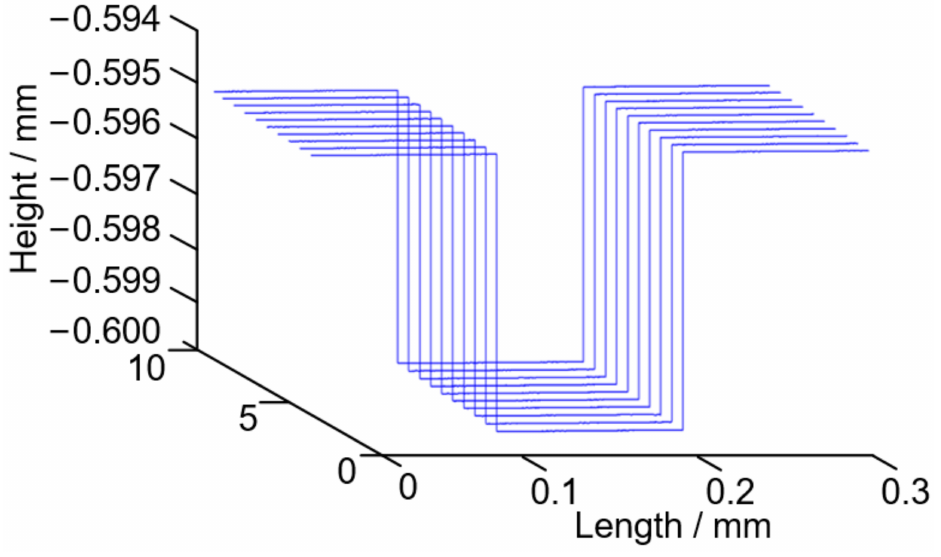
Figure 11. The contour line after stitching.